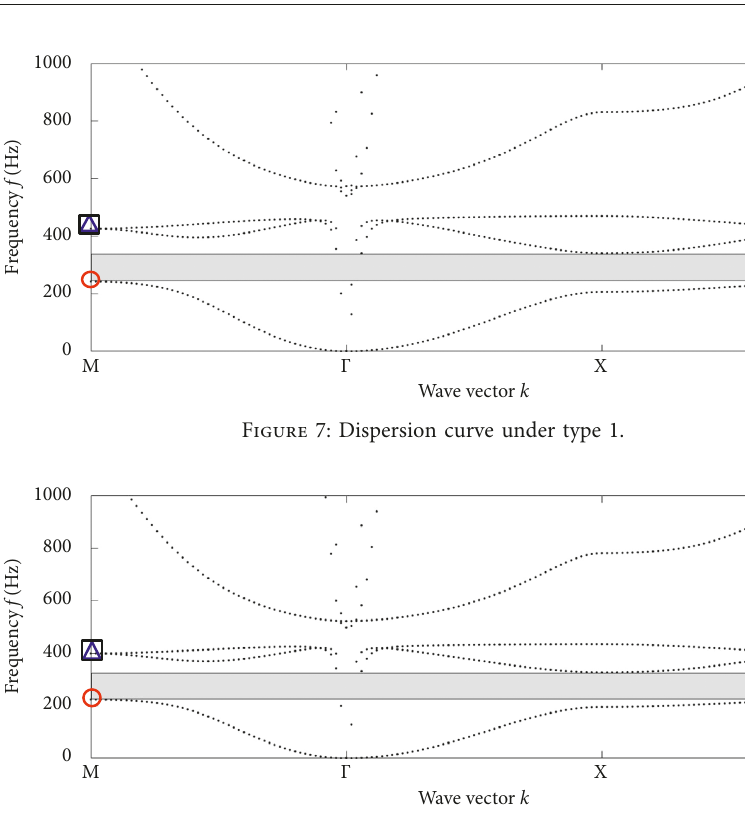
Figure 8: Dispersion curve under type 2.